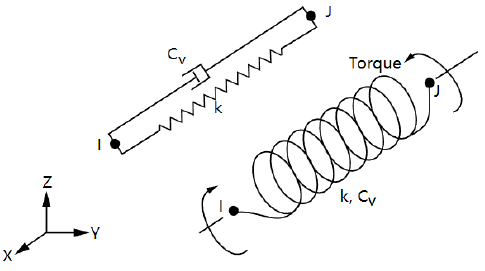
Figure 18. The mechanical principle of diagram of Combin14 spring element.